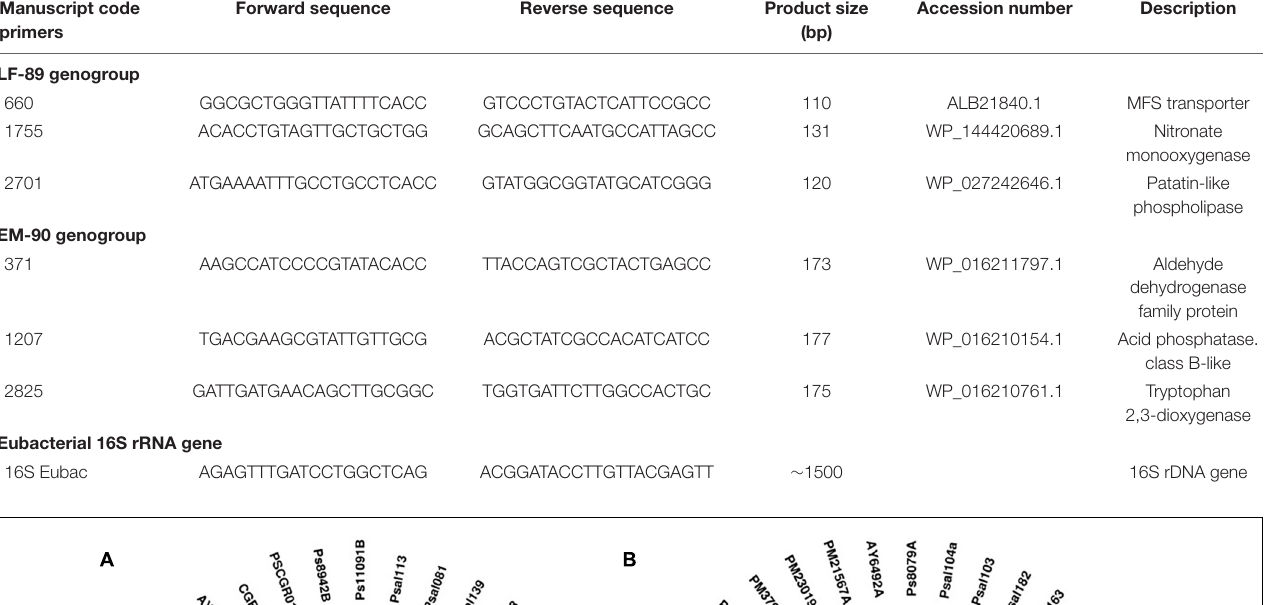
TABLE 1 | List of primers used for genotyping P. salmonis isolates.